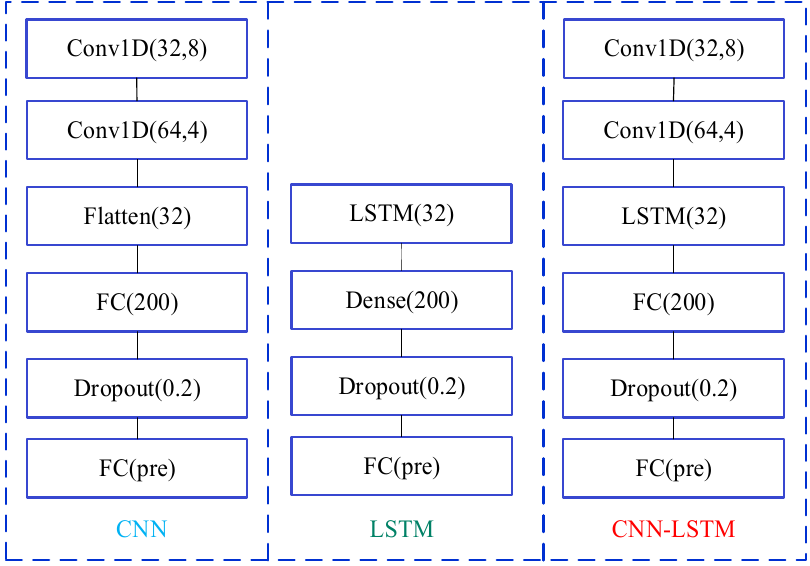
Figure 12. The structure of different models.